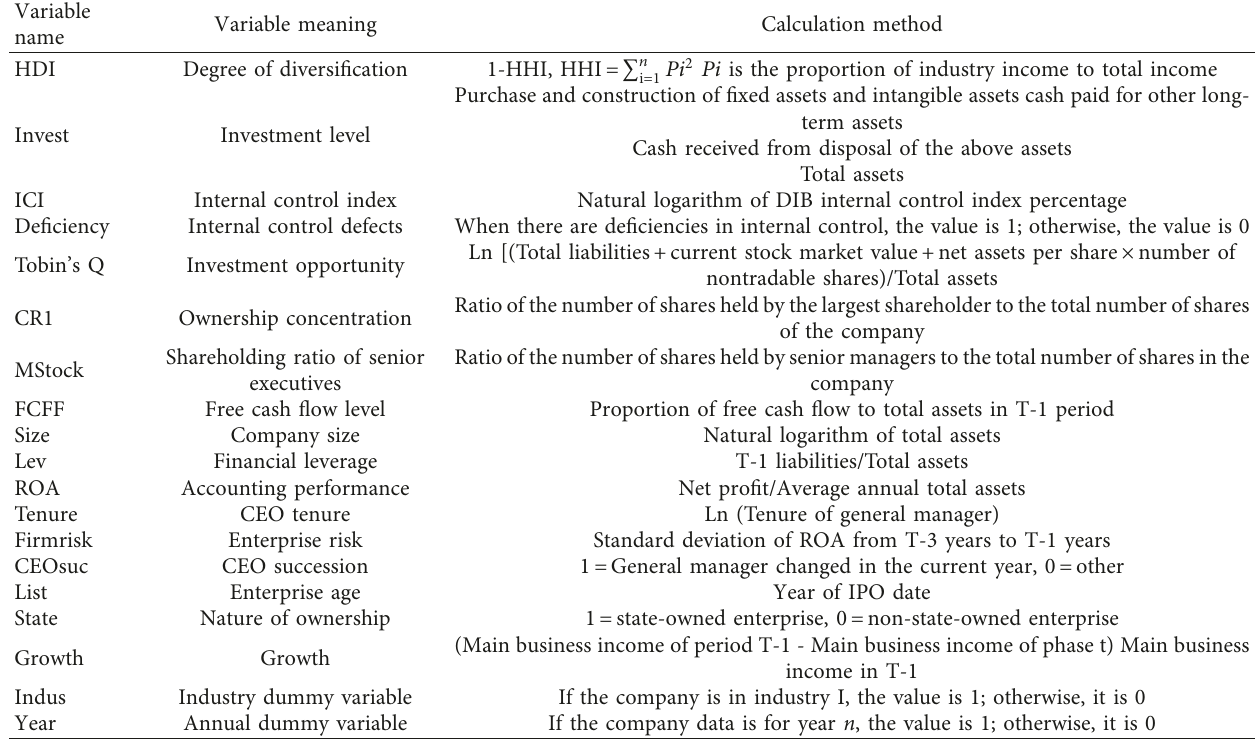
Table 1: Variable